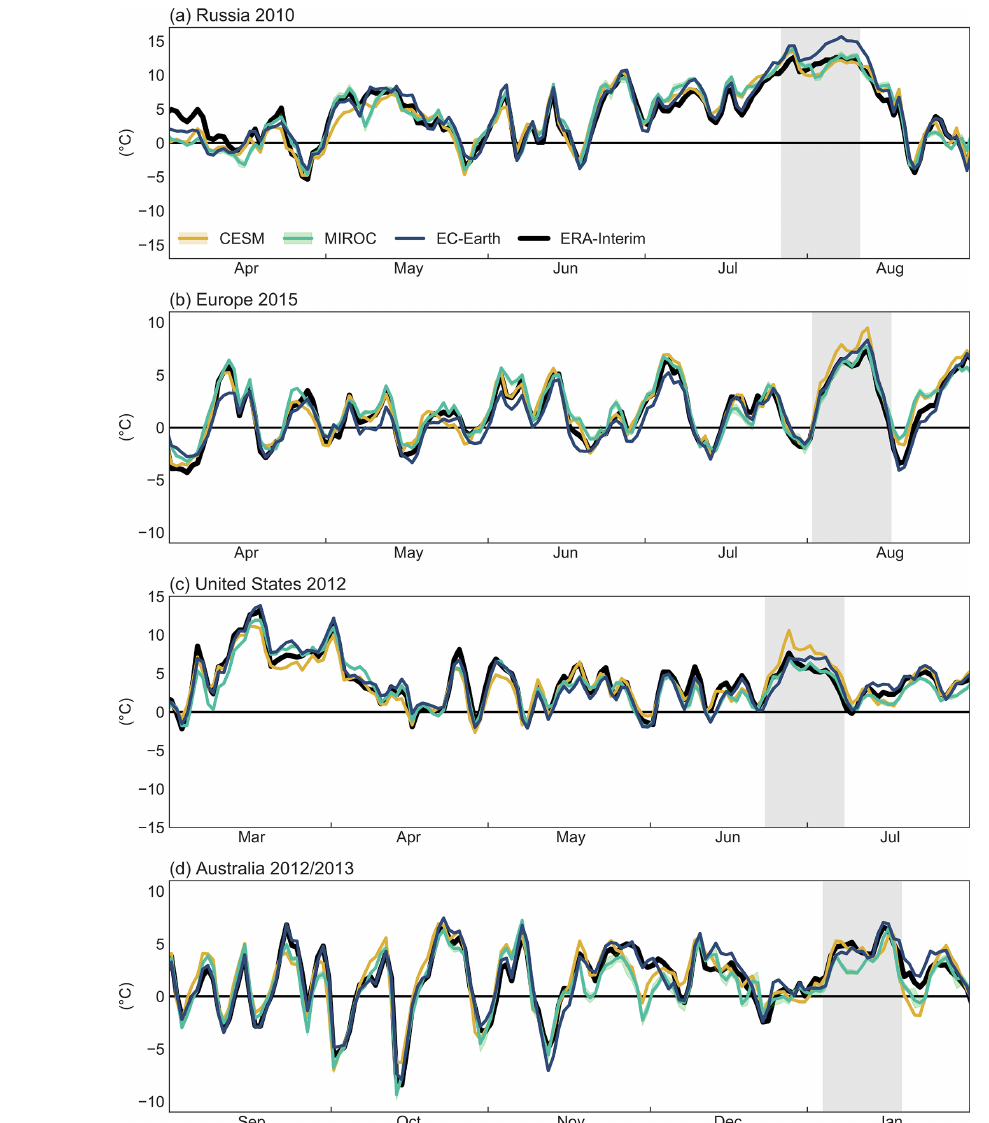
Figure A7. Same as Fig. 6 but for the nudging experiment (AF_SI). The shading shows the full ensemble spread and lines the ensemble mean (or single simulation for